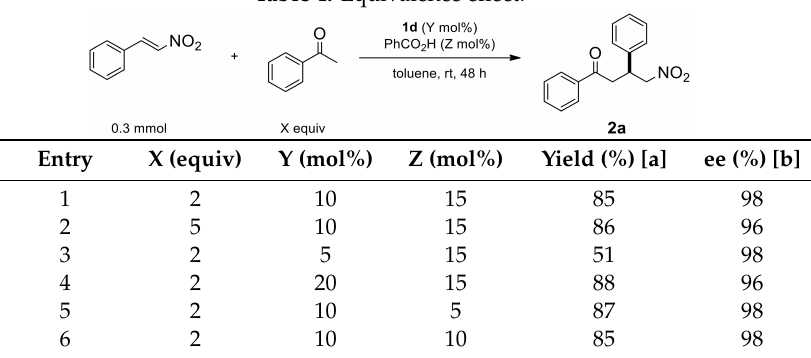
Table 4. Equivalence e ff